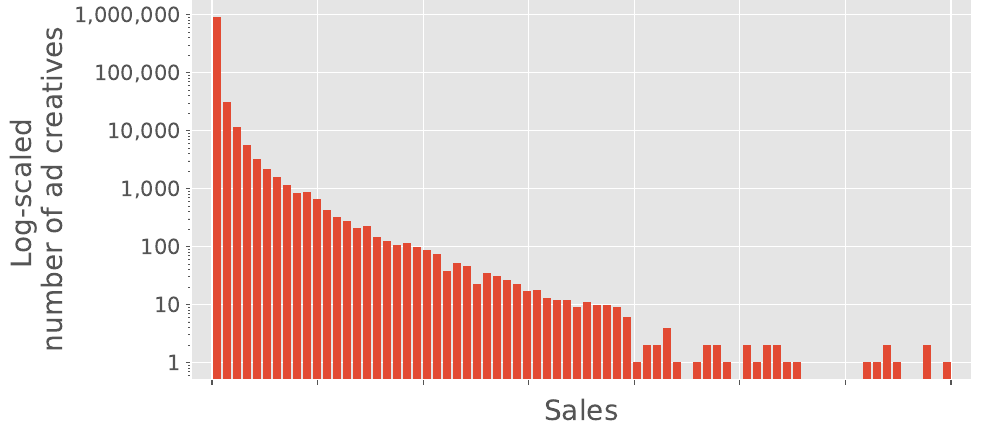
Figure 2. Histogram of ad creative sales in descending order. The y -axis is log-scaled. Most ad creatives are included in the first bin. Because the sales data are confidential, the actual values cannot be disclosed. Thus, relative values are used